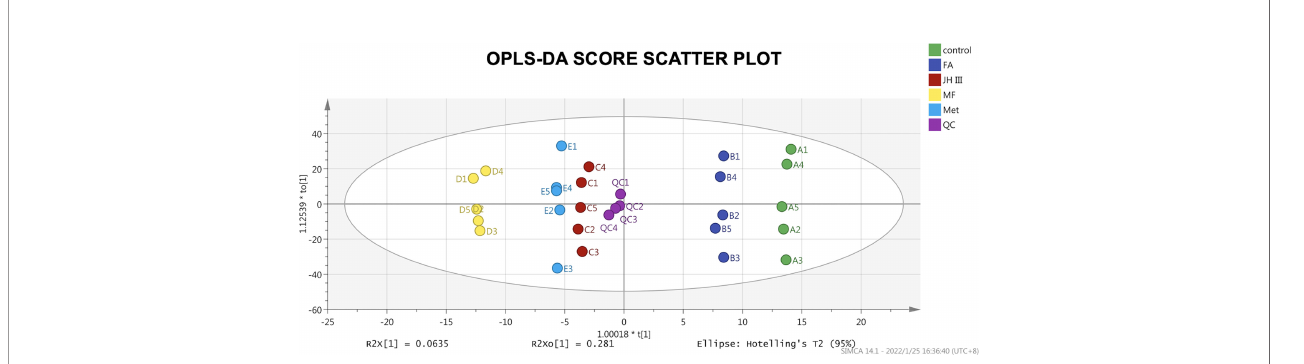
FIGURE 2 | OPLS ‐ DA score scatter plot of all groups. Scatter color represents grouping of the same treatments as shown in the legend, and the primary ID letter A-E are corresponded with control, FA, JH III, MF and Met respectively. The score primary ID number 1-5 are corresponded with the fi ve female crabs. Scores were all within the 95% con fi dence interval (Hotelling ’ s T2